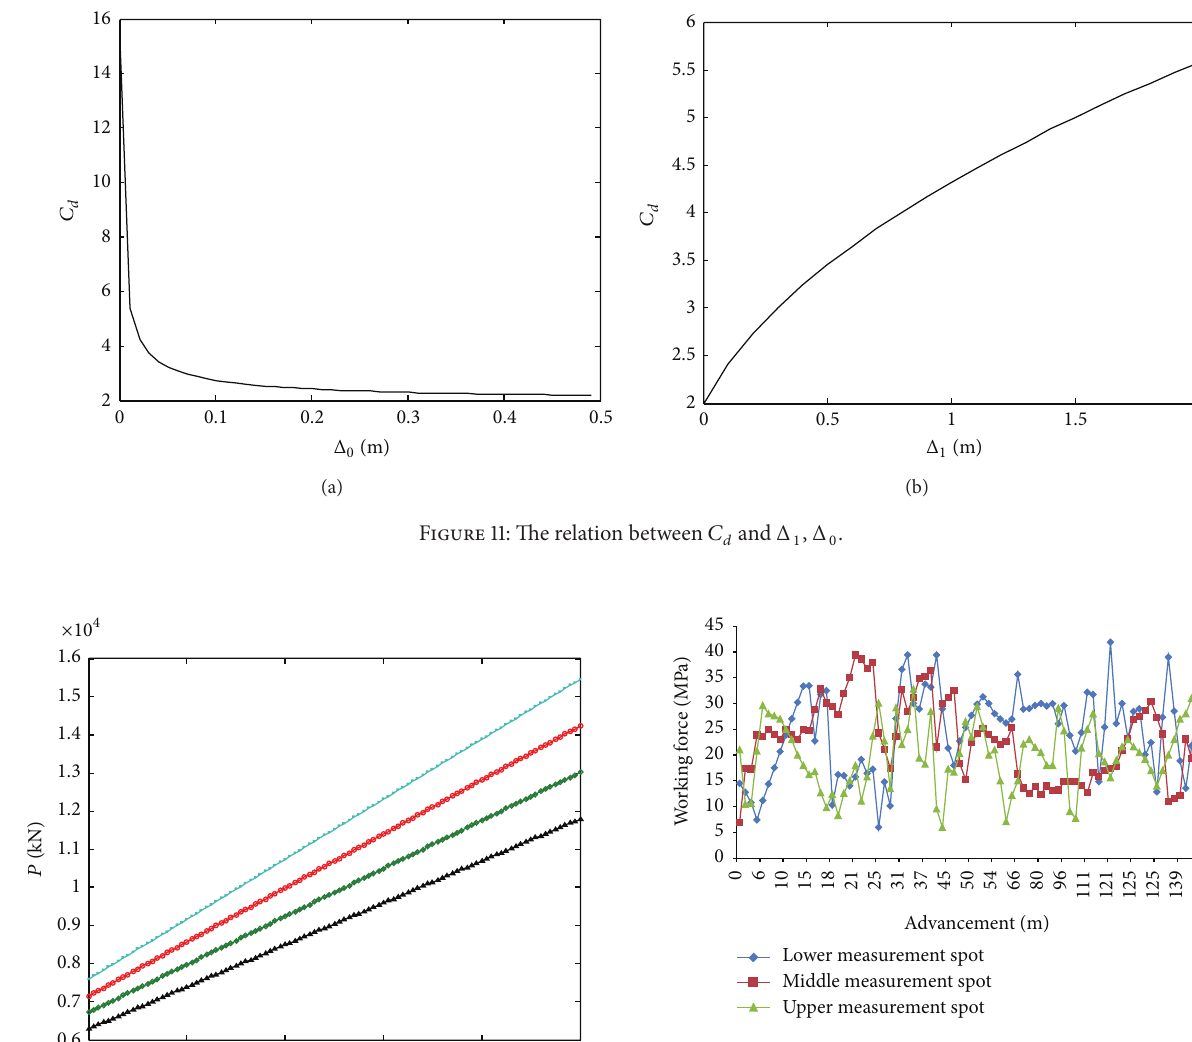
Figure 13: Support work force of No. 15104